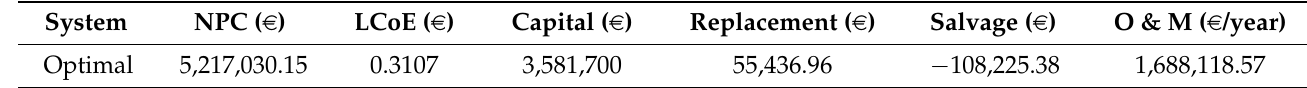
Table 30. Economic characteristics of the optimal configuration of Case 2 Scenario